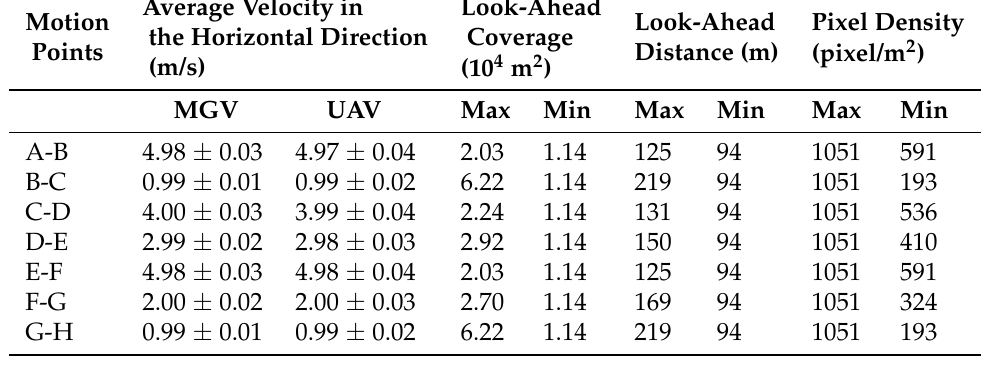
Table 2. Look-ahead distance and coverage for different velocities of the MGV.